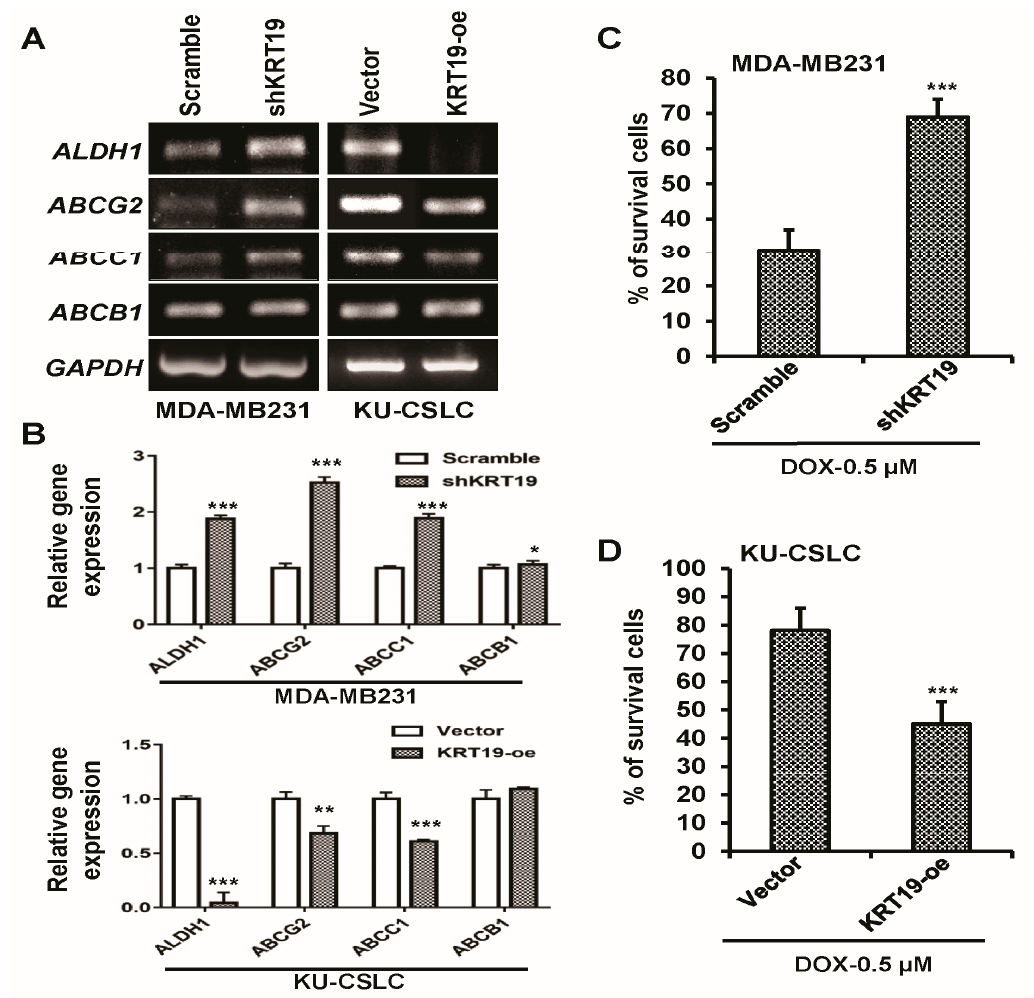
Figure 5. Silencing or overexpression of KRT19 strongly induces or attenuates cancer drug-resistance capacity in MDA-MB231 or KU-CSLC cells. ( A , B ) mRNA expression levels of multidrug-resistant (MDR) marker genes ( ALDH1 , ABCG2 , ABCC1 , and ABCB1 ) were analyzed in the indicated cells using RT-PCR analysis. The specific band intensity was measured using the scanning densitometry program in ImageJ and normalized to that of a housekeeping gene, GAPDH . * p < 0.05; ** p < 0.01; *** p < 0.001; ( C , D ) The effects of KRT19 silencing or overexpression on drug resistance was quantified by cell enumeration after 48 h of doxorubicin treatment (0.5 μ M) in the indicated cells. Data are shown as percentages (%) of survived cells. *** p < 0.001.